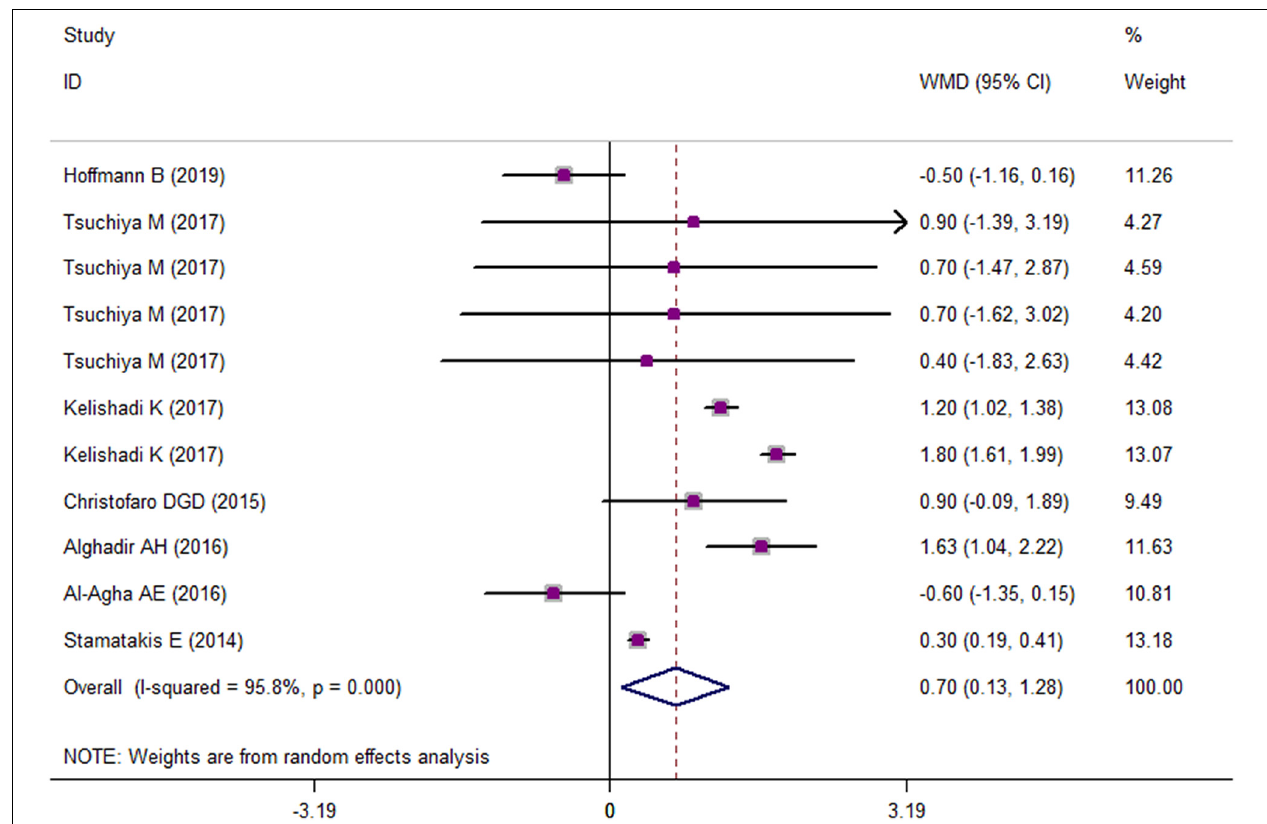
obesity in children and